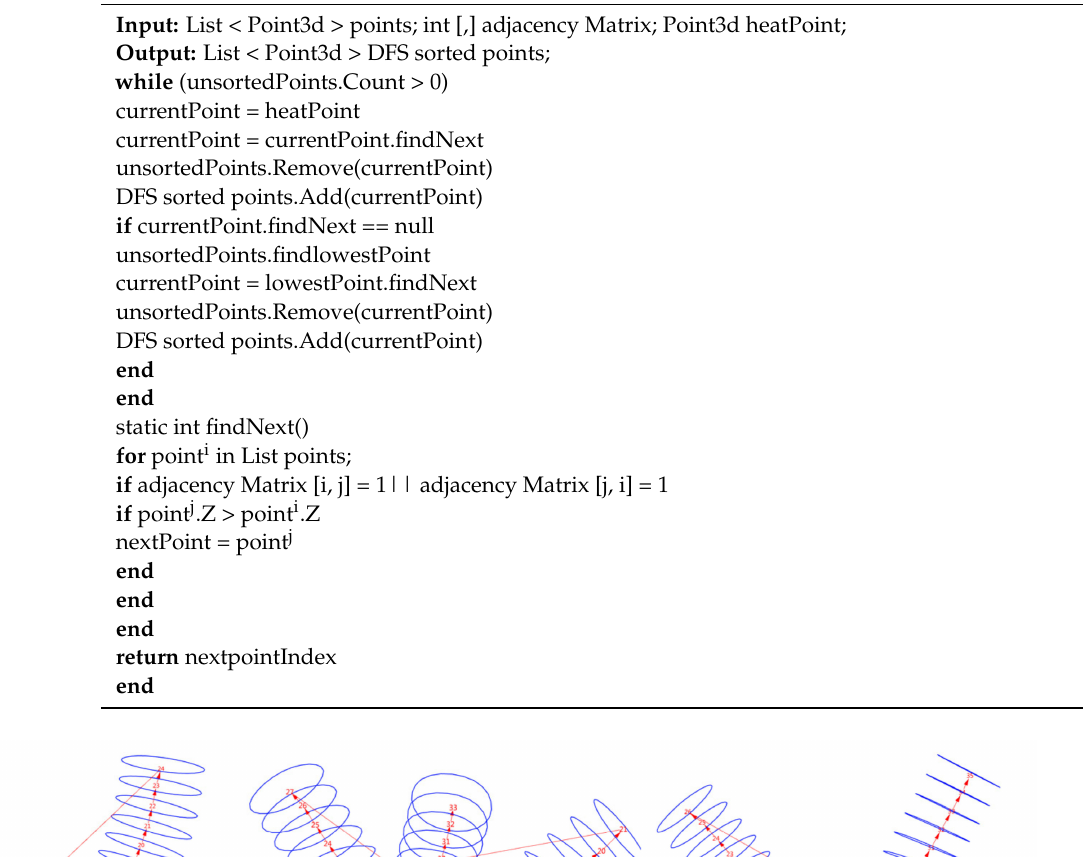
Algorithm 2. DFS Graph Traversal